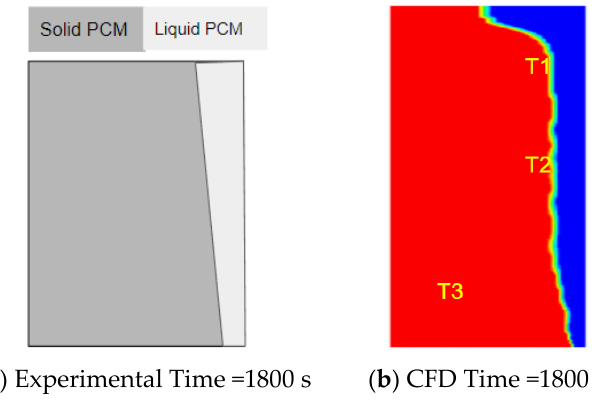
Figure 7. Comparison between the CFD and Experimental [23] data. Table 2. Validated results between the CFD and Experimental